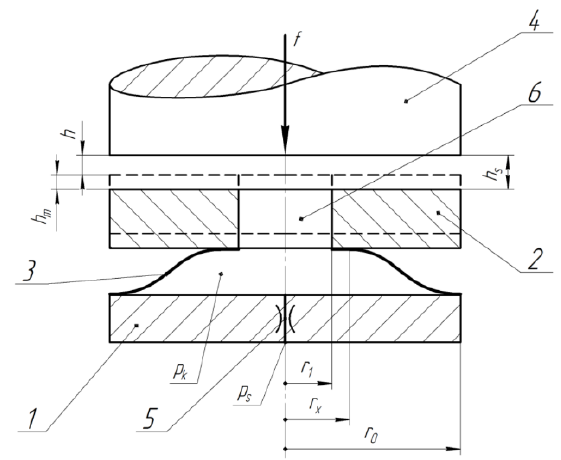
Figure 1. Hydrostatic thrust bearing structure with a membrane displacement